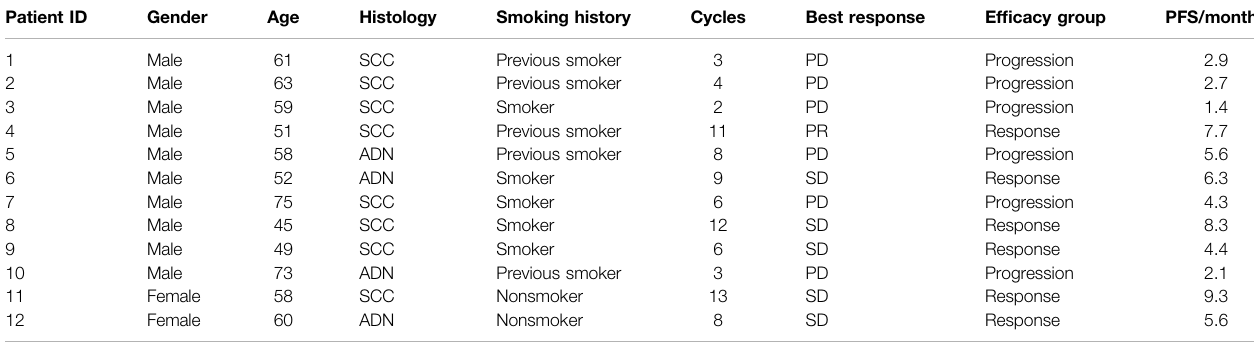
TABLE 1 | Demographic and clinical characteristics of